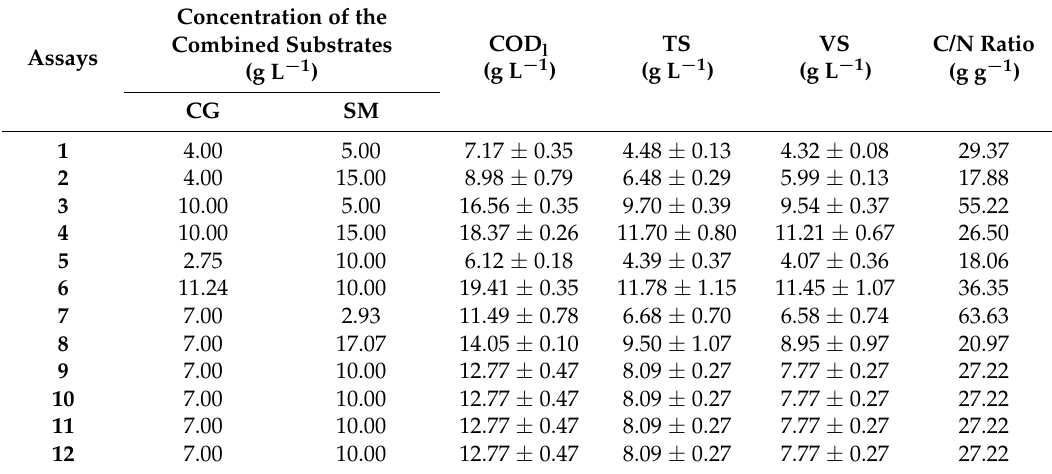
Table 3. Physicochemical characterization of the mixture of crude glycerol (CG) and swine manure (SM) prior to the anaerobic digestion to produce hydrogen. Concentration of Assays